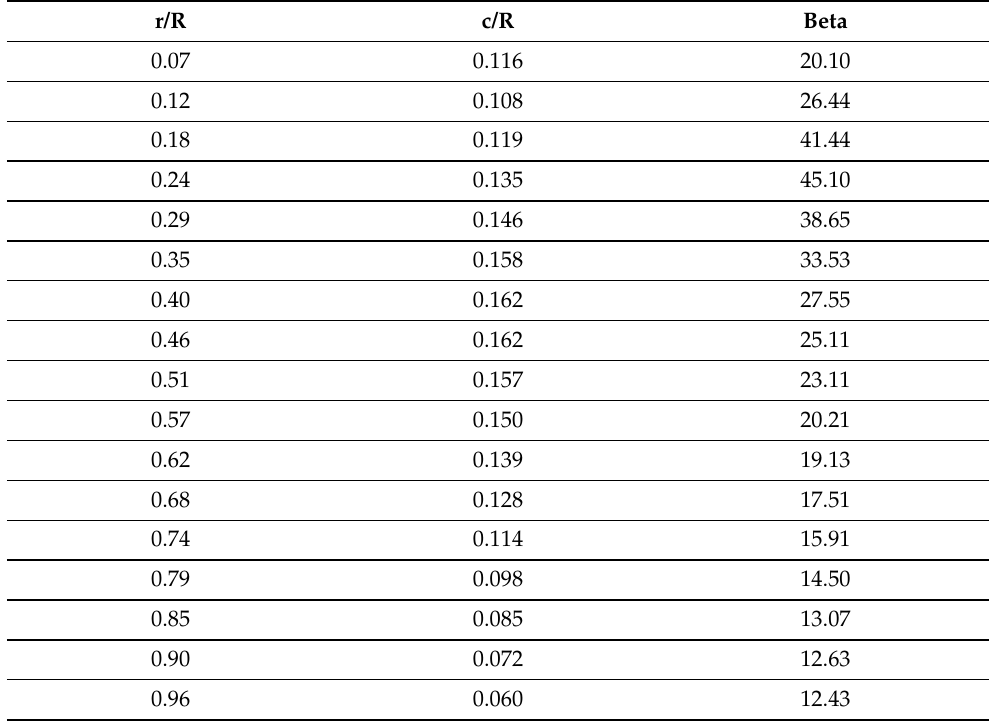
Table A4. APC 18 × 12 propeller geometry.